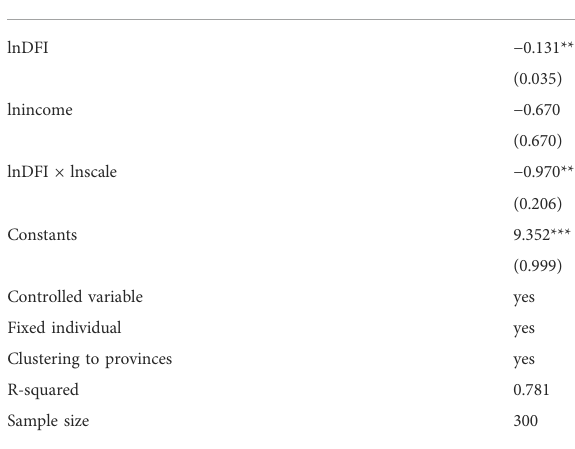
TABLE 7 Results of the test for moderating